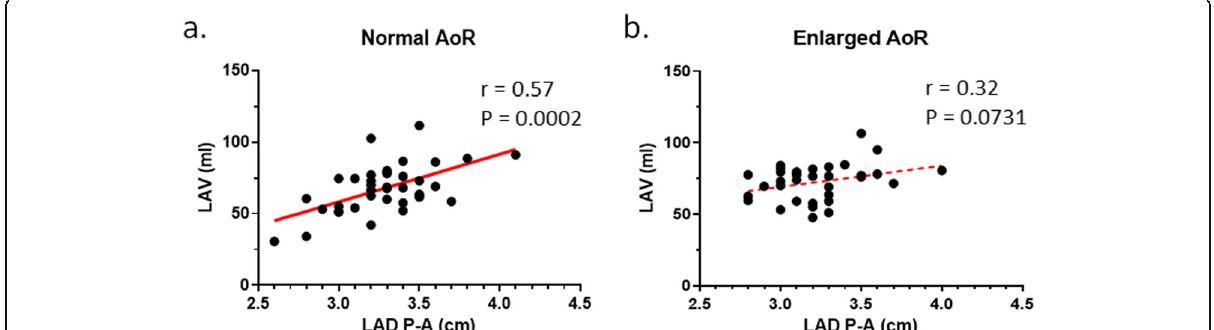
Fig. 4 Linear regression analysis between LAD P-A and LAV. Analysis was performed for A normal size AoR and B enlarged AoR. The slope of the fitted line was significantly different from zero only for individuals with normal size aortic